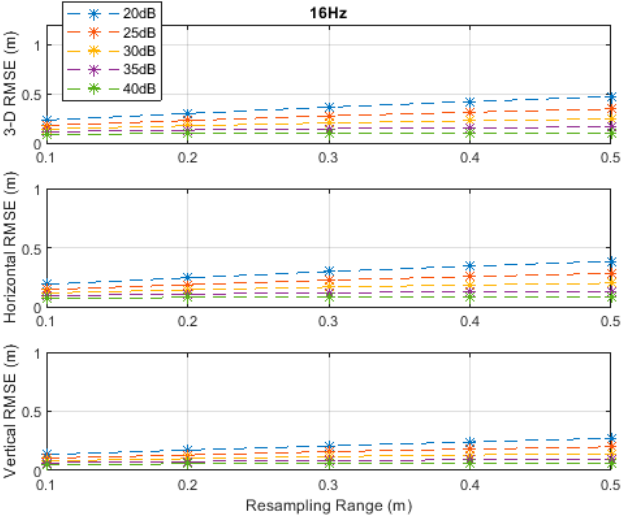
Figure 5. RMSE results along the 3D linear path at a measurement update rate of 8 Hz.